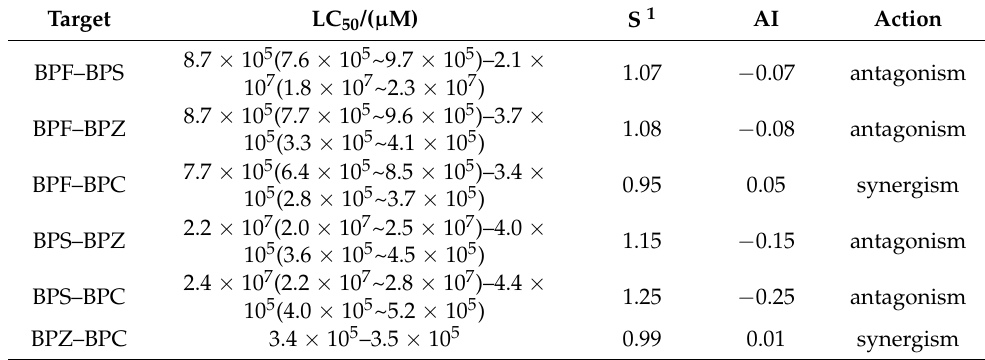
Table 2. Combined toxicity of BPZ, BPC, BPF, and BPS to zebrafish after 96 h.